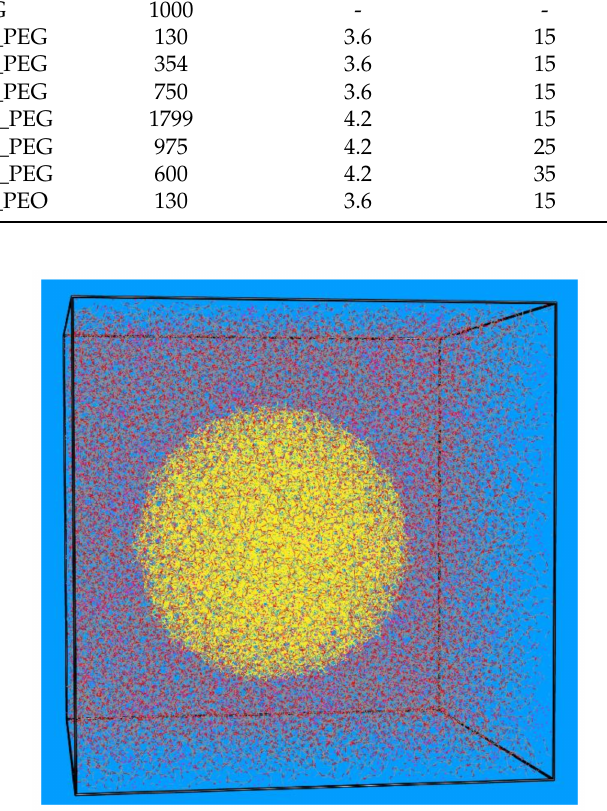
Figure 1. Typical atomistic configuration in box-relative coordinates of the d9_v15_PEG system (system 4 in Table 1) containing 750 PEG chains with degree of polymerization N = 41 and one spherical silica nanoparticle of diameter d = 9 nm in a cubic simulation cell with dimensions equal to 138 Å × 138 Å × 138 Å. Carbon, oxygen, hydrogen and silica atoms are shown with gray, red, white, and yellow color,